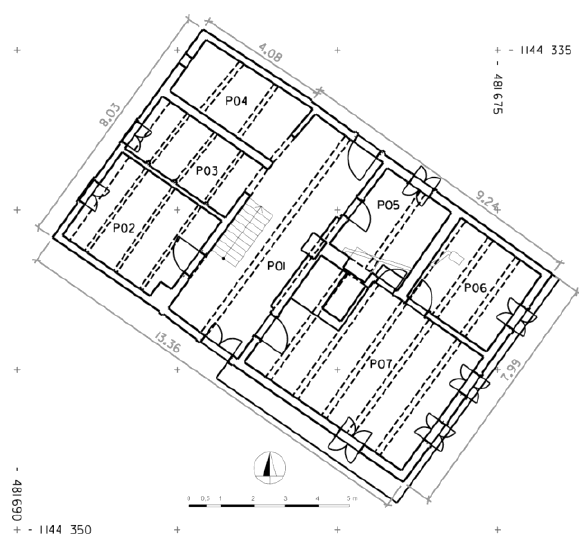
Figure 4. Example of the final ground plan of the examined building, Vigantice (Vsetín